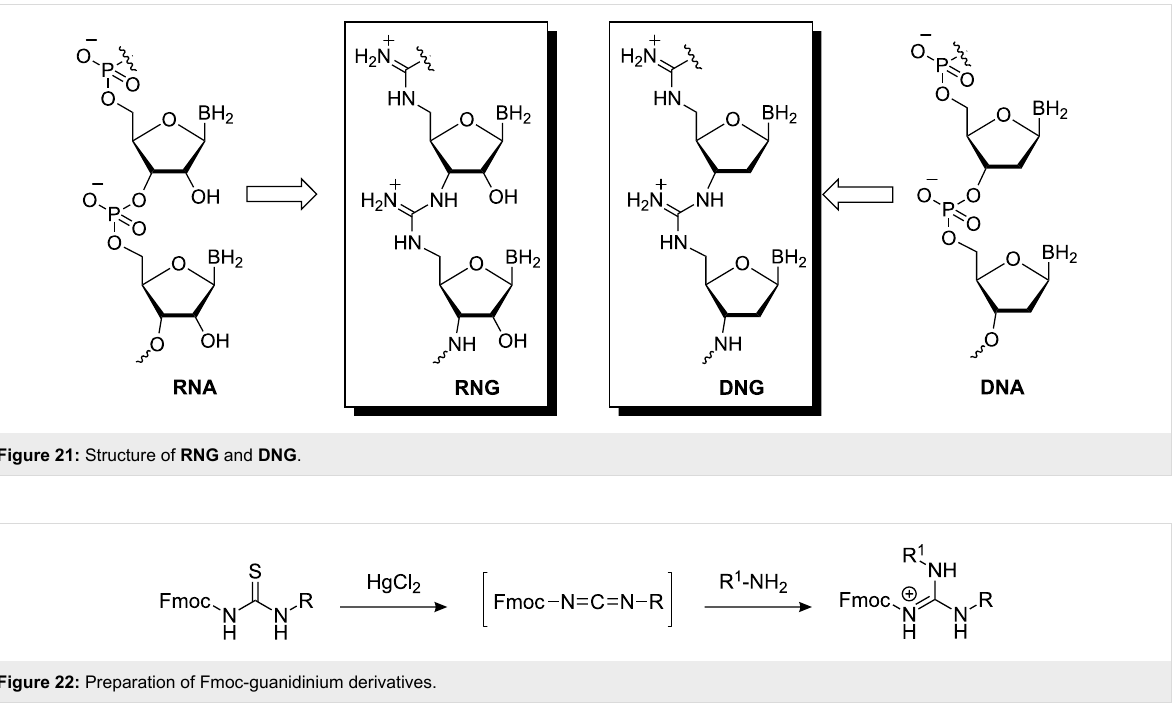
Figure 22: Preparation of Fmoc-guanidinium derivatives.